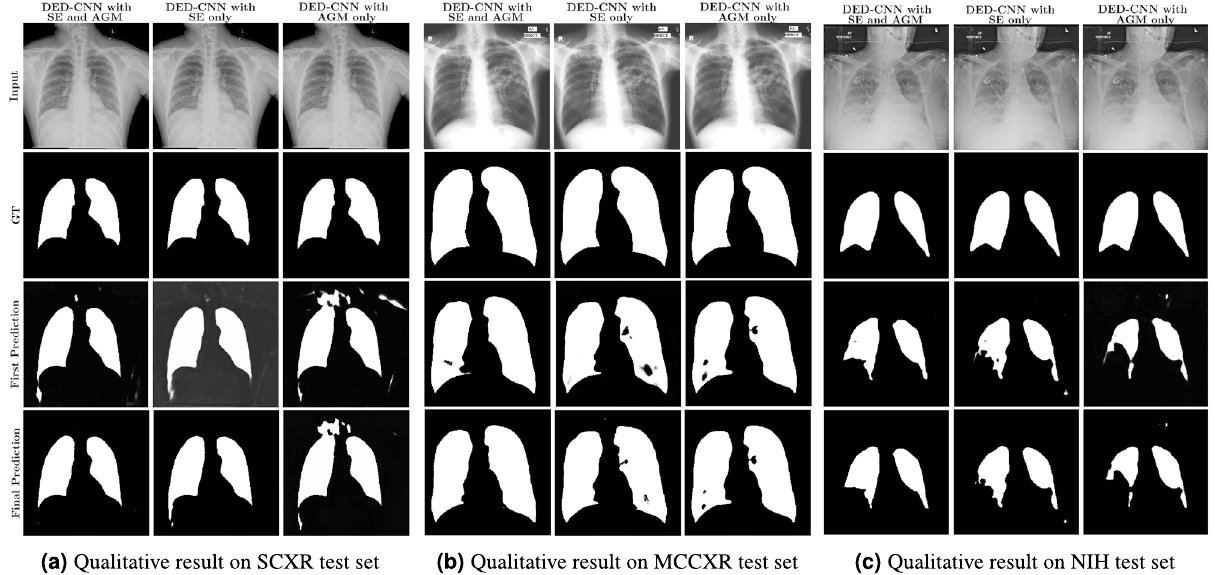
Figure 6. Qualitative results of the proposed DED-CNN in the cross-dataset setting where all the models are trained on different dataset and tested on different dataset. From left to right: the first row is the input image, the second row represent the ground truths, the third row is the prediction result of the first encode-decoder model in DED-CNN framework and the last row represent the results of the second encoder–decoder model in the DED-CNN framework. All the models are trained and test in cross dataset configuration.